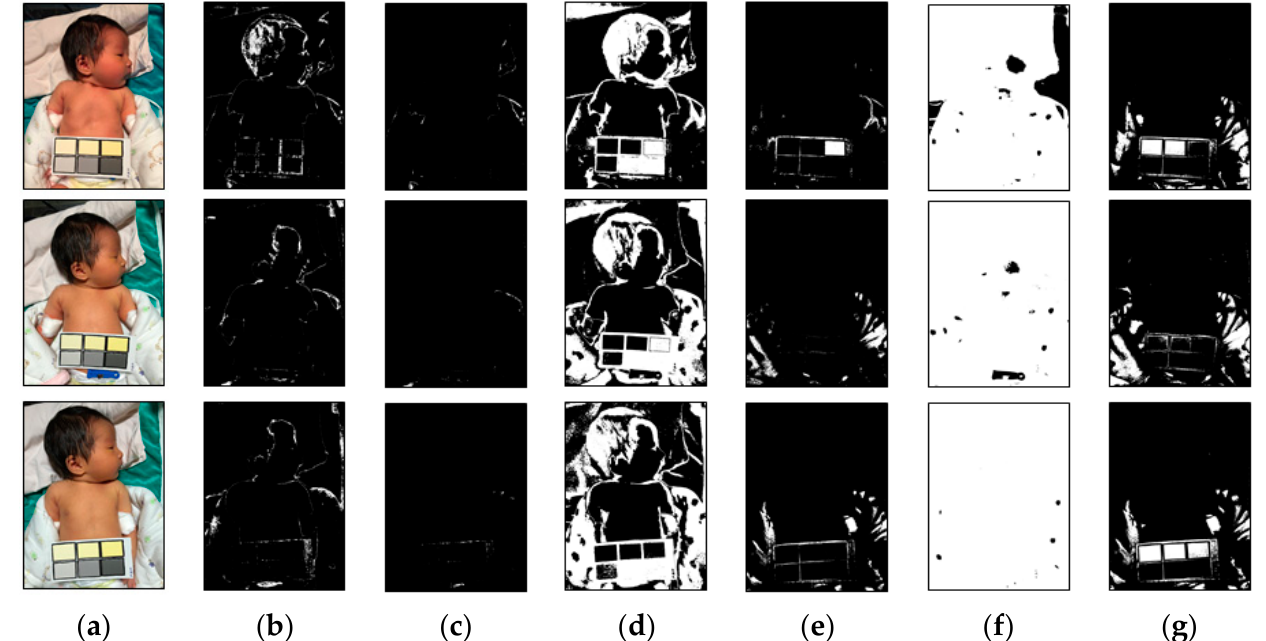
Figure 5. Results of original images after filtering. ( a ) Original images with various color temperatures (28, 48, and 65 K from top to bottom). ( b , d , f ) W r is 0.1, 0.5, and 1.5. W p is 0.1 for all color temperatures. ( c , e , g ) Remaining white points after filtering.